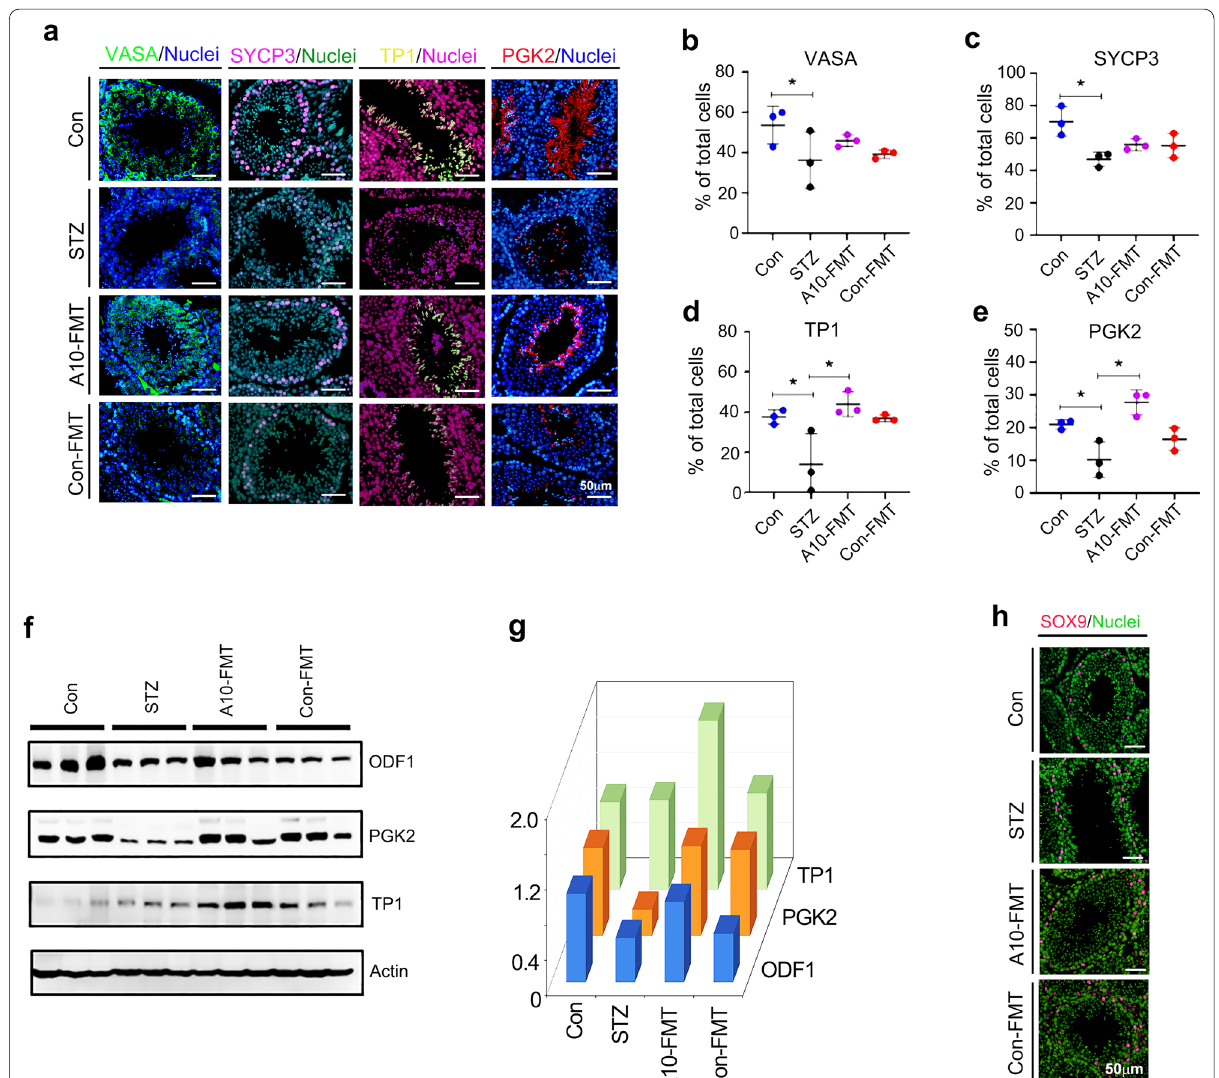
Fig. 5 A10-FMT improved spermatogenesis process. a IHF staining of testicular germ cell marker VASA , meiosis marker SYCP3 , sperm protein PGK2 , and transition protein 1 ( TP1 ) in each treatment. Scale bar: 50 μm. n 3/group. b Quantitative data for VASA IHF staining. The y-axis represents ≥ the percentage of total cell. The x-axis represents the treatment. * p < 0.05. c Quantitative data for SYCP3 IHF staining. The y-axis represents the percentage of total cell. The x-axis represents the treatment. * p < 0.05. d Quantitative data for TP1 IHF staining. The y-axis represents the percentage of total cell. The x-axis represents the treatment. * p < 0.05. e Quantitative data for PGK2 IHF staining. The y-axis represents the percentage of total cells. The x-axis represents the treatment. * p < 0.05. f Western blotting analysis of the proteins of important genes for spermatogenesis in each treatment. n 3/group. g Quantitative data for Western blotting analysis. h IHF staining of Sertoli cell marker ≥